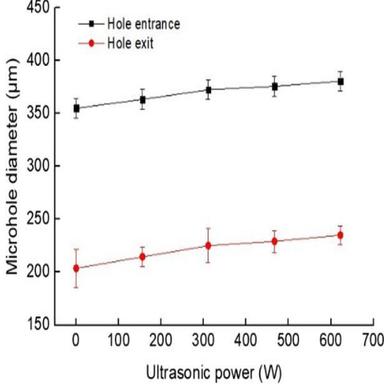
Influence of the ultrasonic power on the hole diameter drilled using five laser pulses.